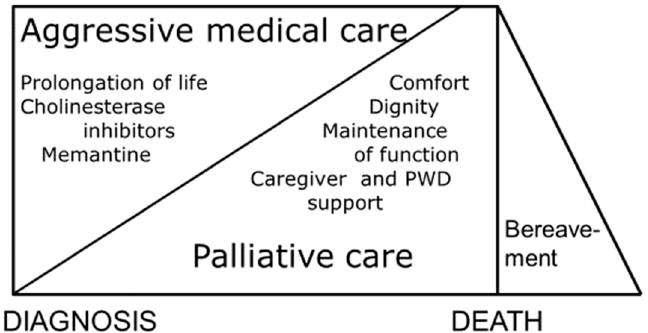
Figure 1. Types of dementia care (PWD = person with dementia) (reprinted with permission from Progress in Palliative Care 21(3), 146–150, 2013) [3].